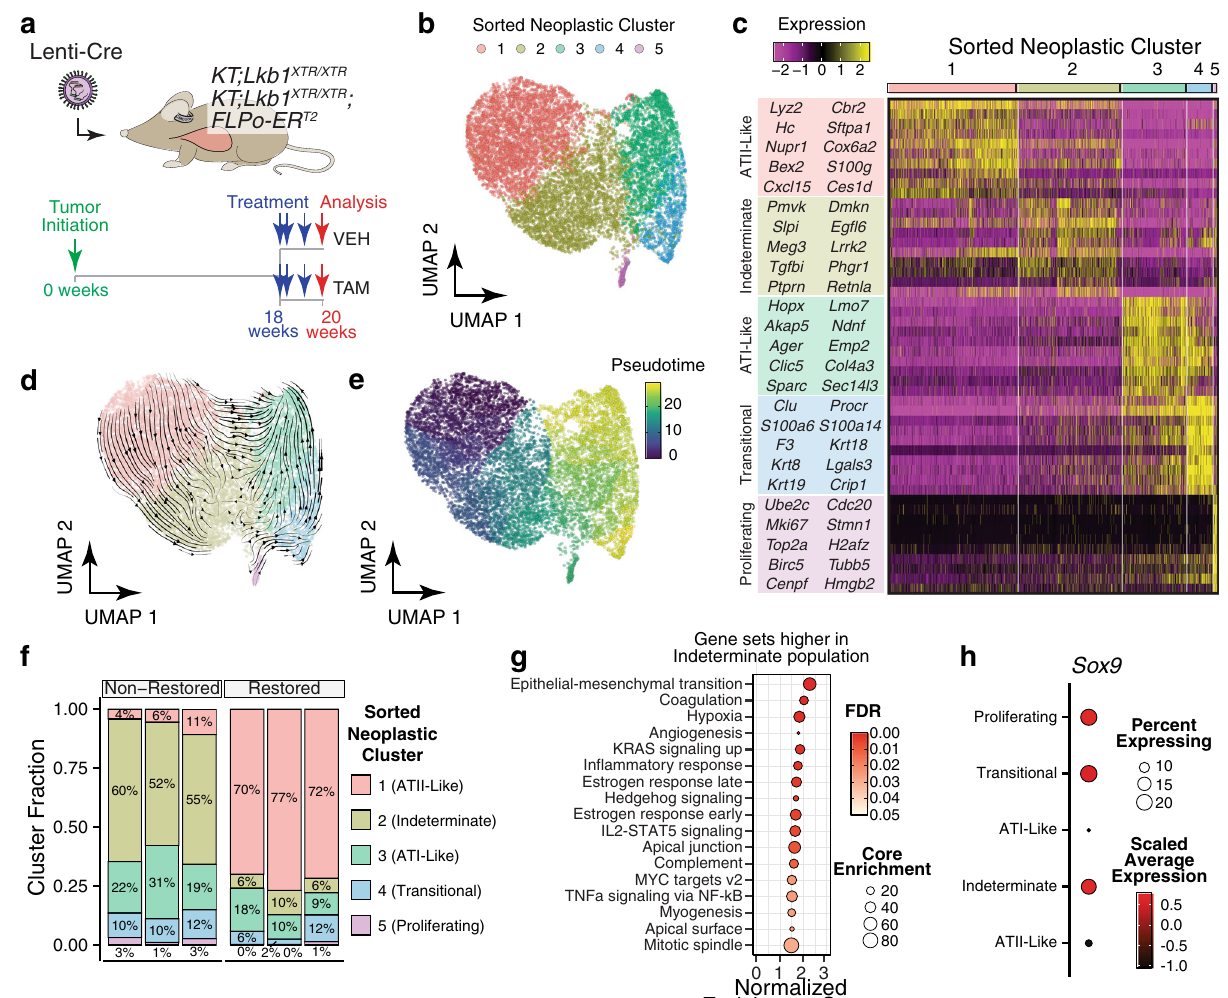
Fig. 4 Lkb1 restoration enforces an alveolar type II-like cell state. a Pro fi ling the acute transcriptional response to Lkb1 restoration within established tumors at single-cell resolution. KT;Lkb1 XTR/XTR -vehicle, n = 1 mouse; KT;Lkb1 XTR/XTR -tamoxifen, n = 1 mouse; KT;Lkb1 XTR/XTR ;FLPo-ER T2 -vehicle, n = 1 mouse; KT;Lkb1 XTR/XTR ;FLPo-ER T2 -tamoxifen, n = 3 mice. b Single-cell RNA-seq on tdTomato positive neoplastic cells from Lkb1 -restored and